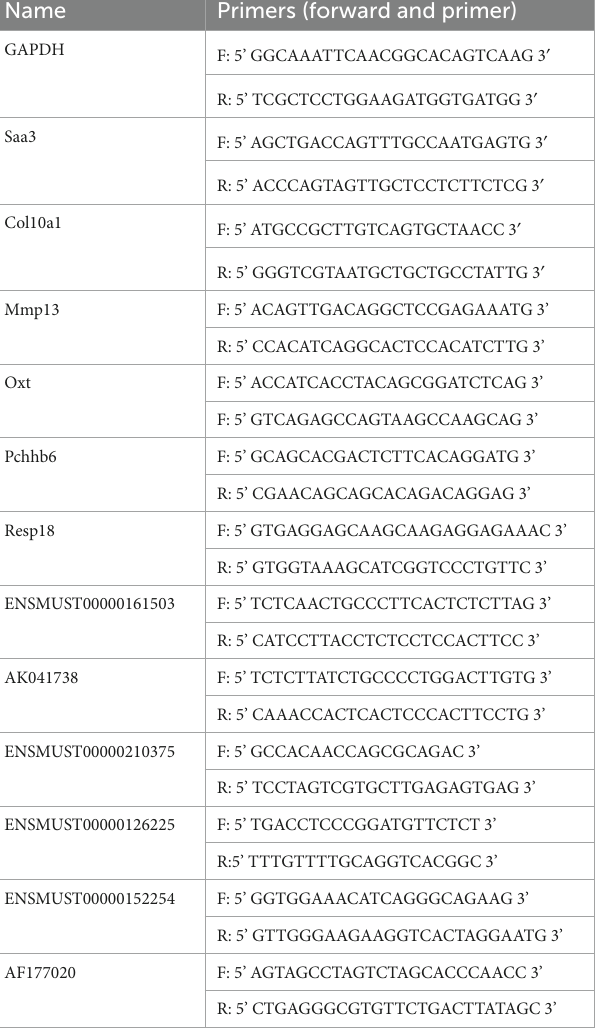
screened hub clusters according to filter criteria (degree cutoff: 0.2,